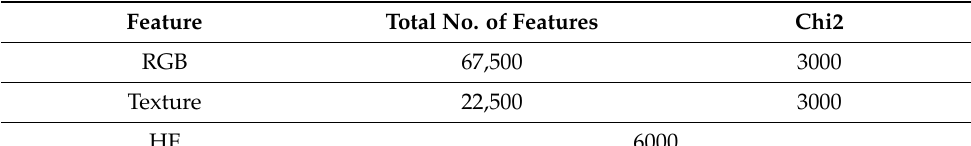
Table 4. Number of features.